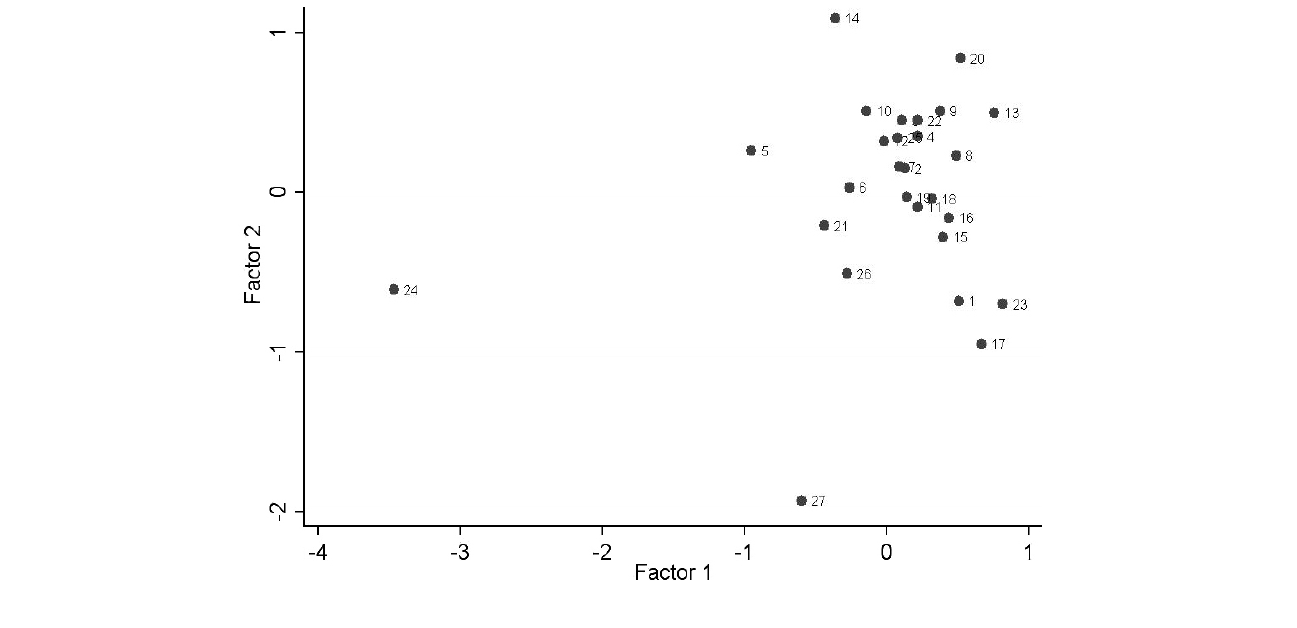
Fig. 7 . A two-dimensional MDS map of conservationists, according to similarity of pile-sorting consequences if the Crocodile River stops flowing (stress =